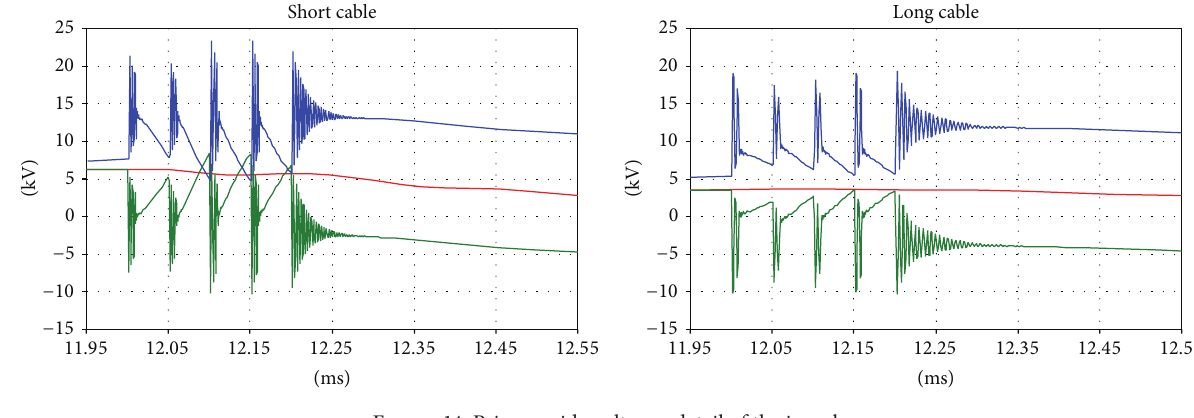
Figure 14: Primary side voltages: detail of the inrush. Table 1: The series parameters for the MV cable